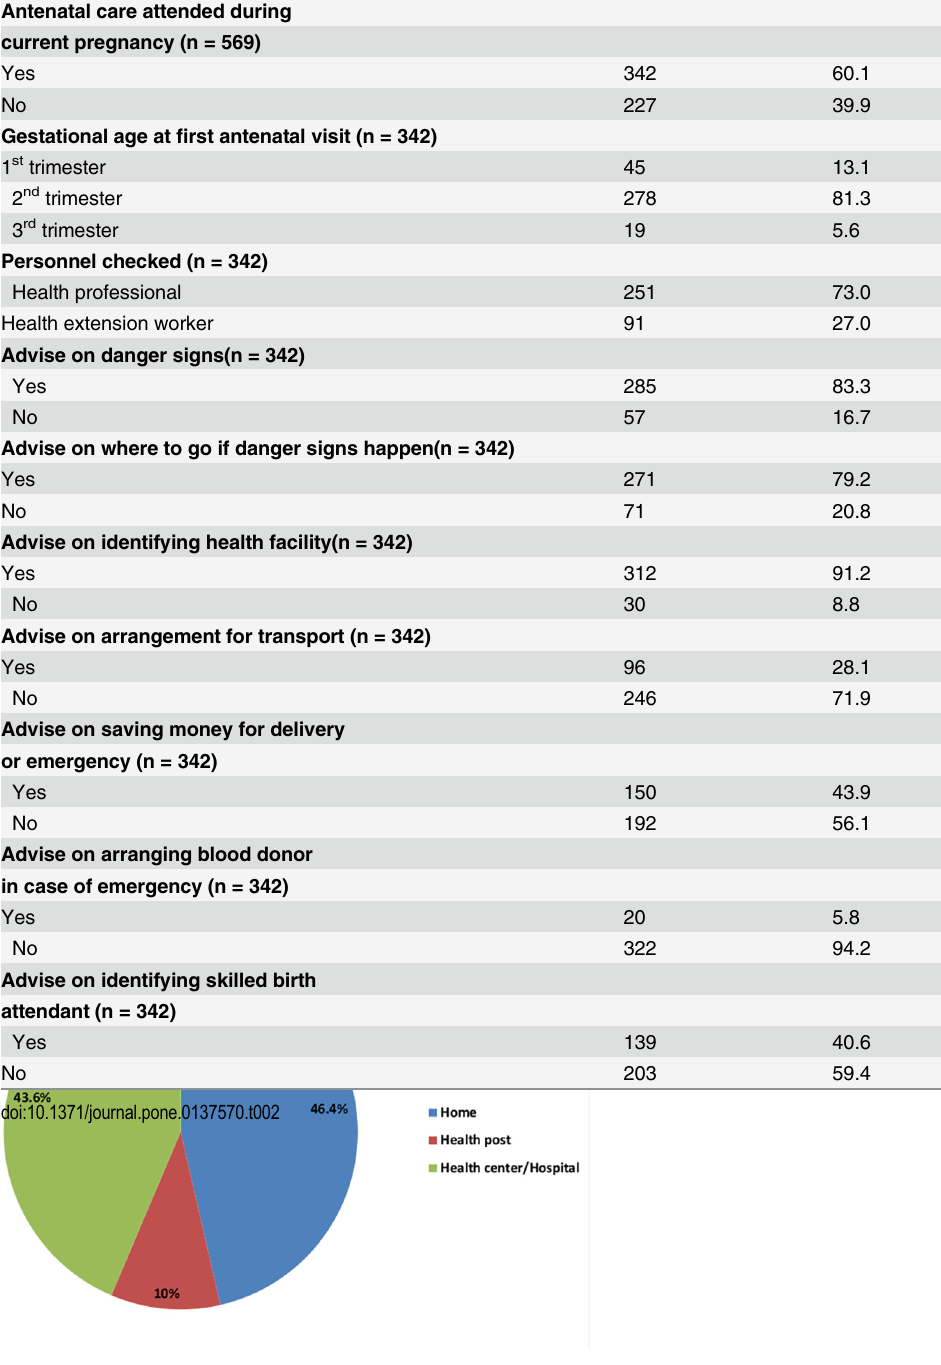
Table 2. Antenatal care services and advice given among pregnant women in Duguna Fango District, 2013 (n = 569). This table shows antenatal care services and advice given among pregnant women.